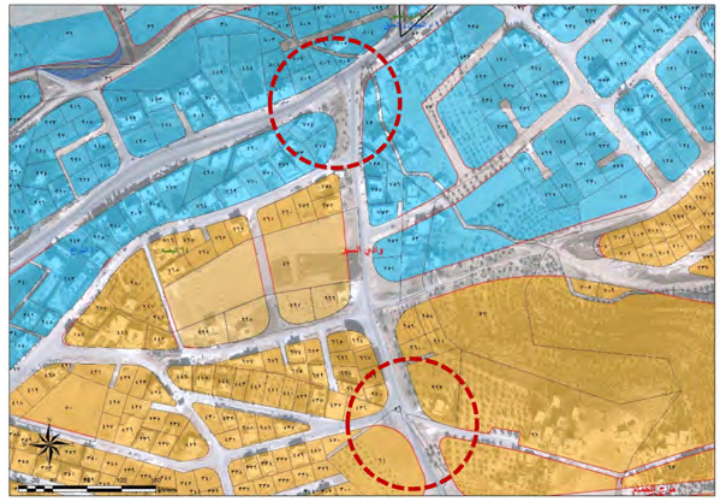
Figure 29. Near high voltage site land use over aerial view map. Source: GAM- GIS for the author (2016). In general, in terms of the contaminated and hazardous sites potential brownfield typology, much of the investi-